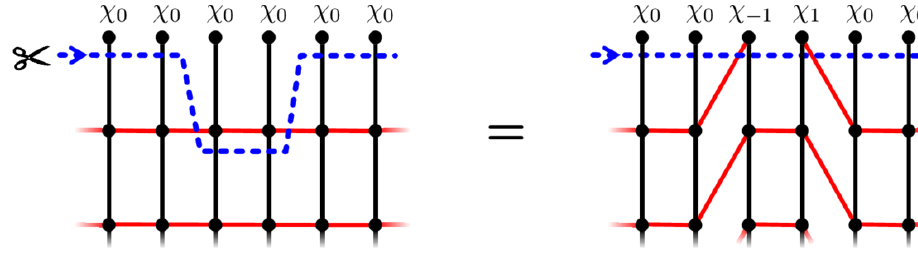
Figure 6 . Another example of a cut which, instead of moving magnons around, creates a magnon{ anti-magnon